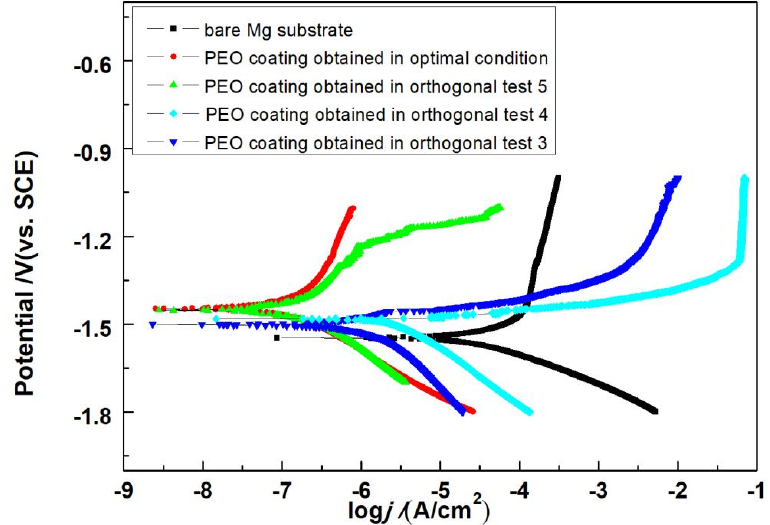
Figure 8. XRD patterns of PEO coatings ( a ) optimal condition, ( b ) test 3, ( c ) test 4 and ( d ) test 5. Optimal conditions are: electrolyte compositions of 45 g/L NaOH, 50 g/L Na 2 SiO 3 and 90 g/L Na 2 B 4 O 7 with electric parameters of current density 1 A/dm 2 ; pulse frequency 200 Hz; duty cycle 10% and oxidation time 15 min.